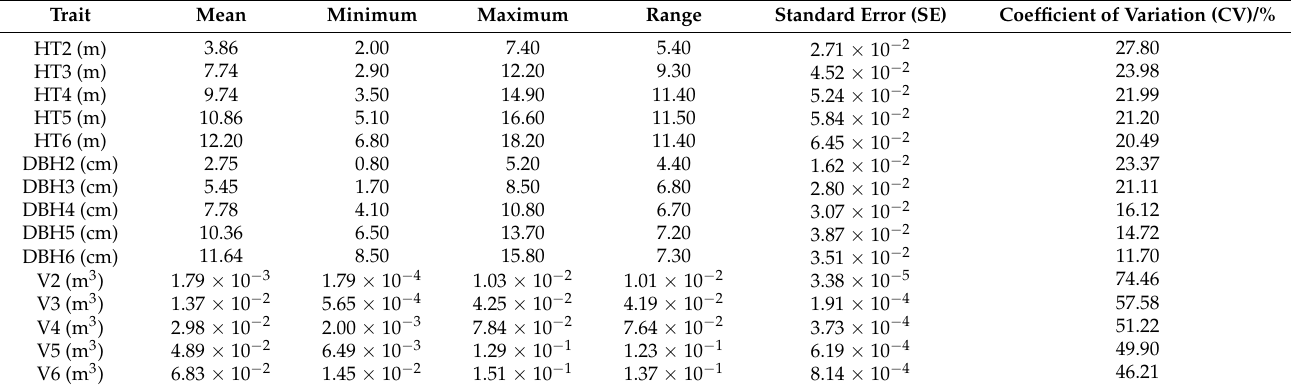
Table 2. Descriptive statistics for growth traits at different ages in the progeny test population of N. cadamba. Trait